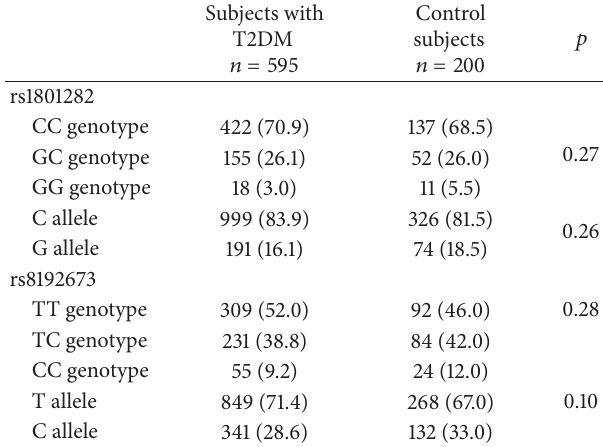
Table 2: Genotype distribution and allele frequencies of the poly- morphisms rs1801282 and rs8192673 in patients with T2DM and in control